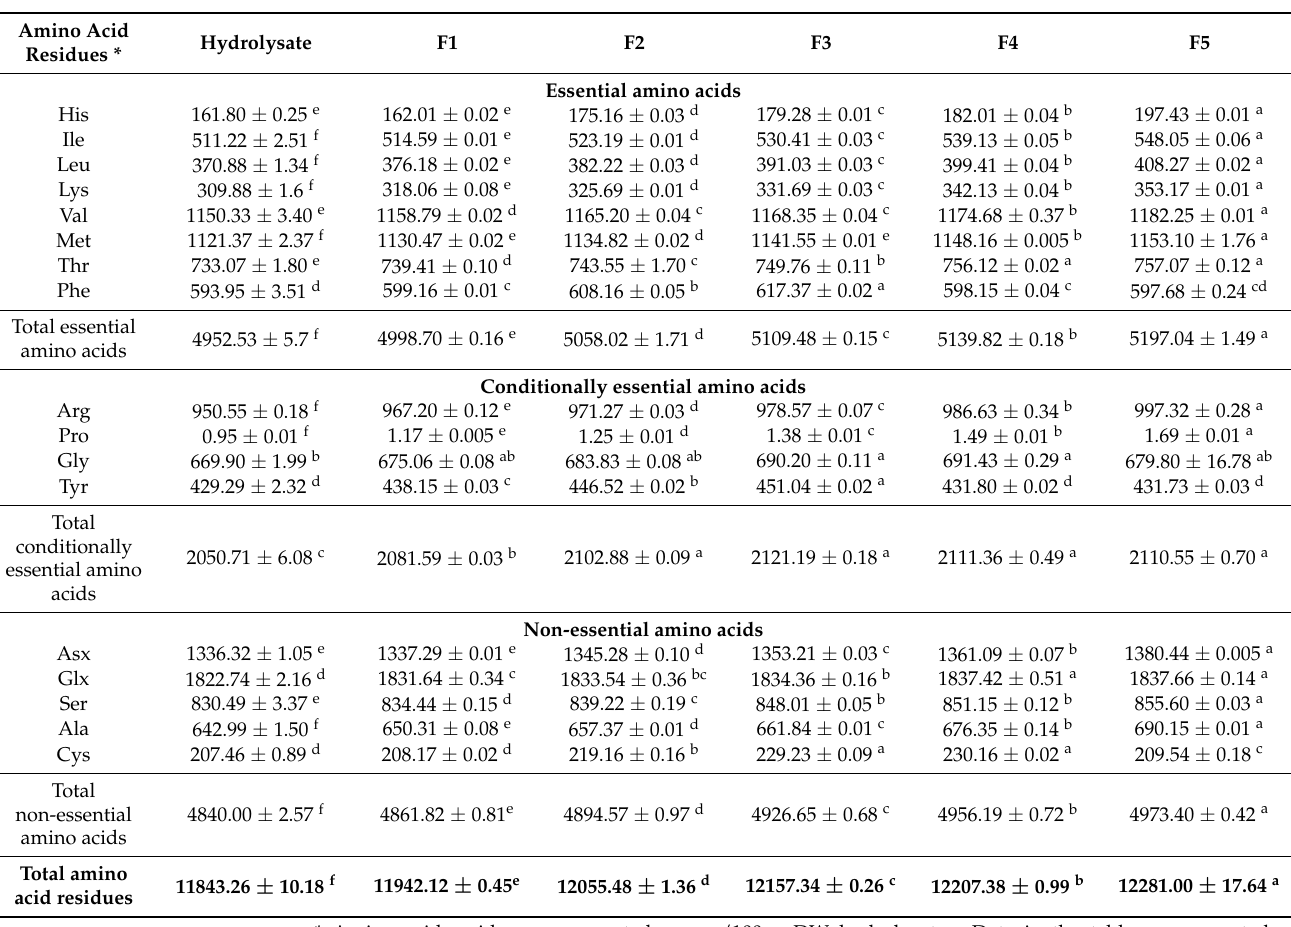
Table 2. Amino acid composition of full hydrolysate of giant kelp and its ultrafiltered fractions of different